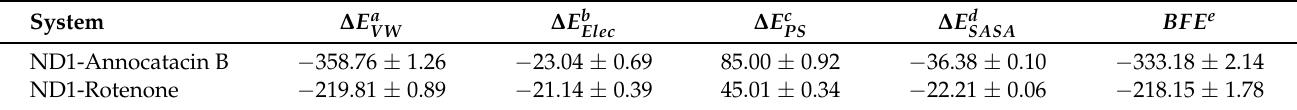
Table 5. Average MM/PBSA free energies of ND1 complexes.